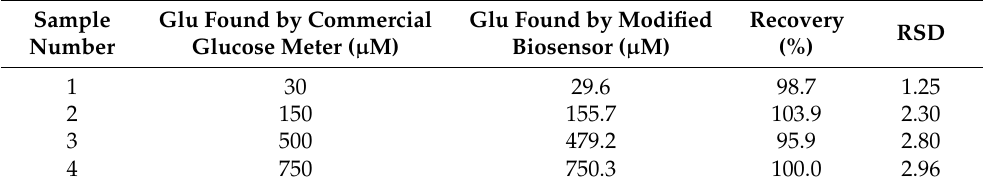
Table 4. Determination of Glu in plasma